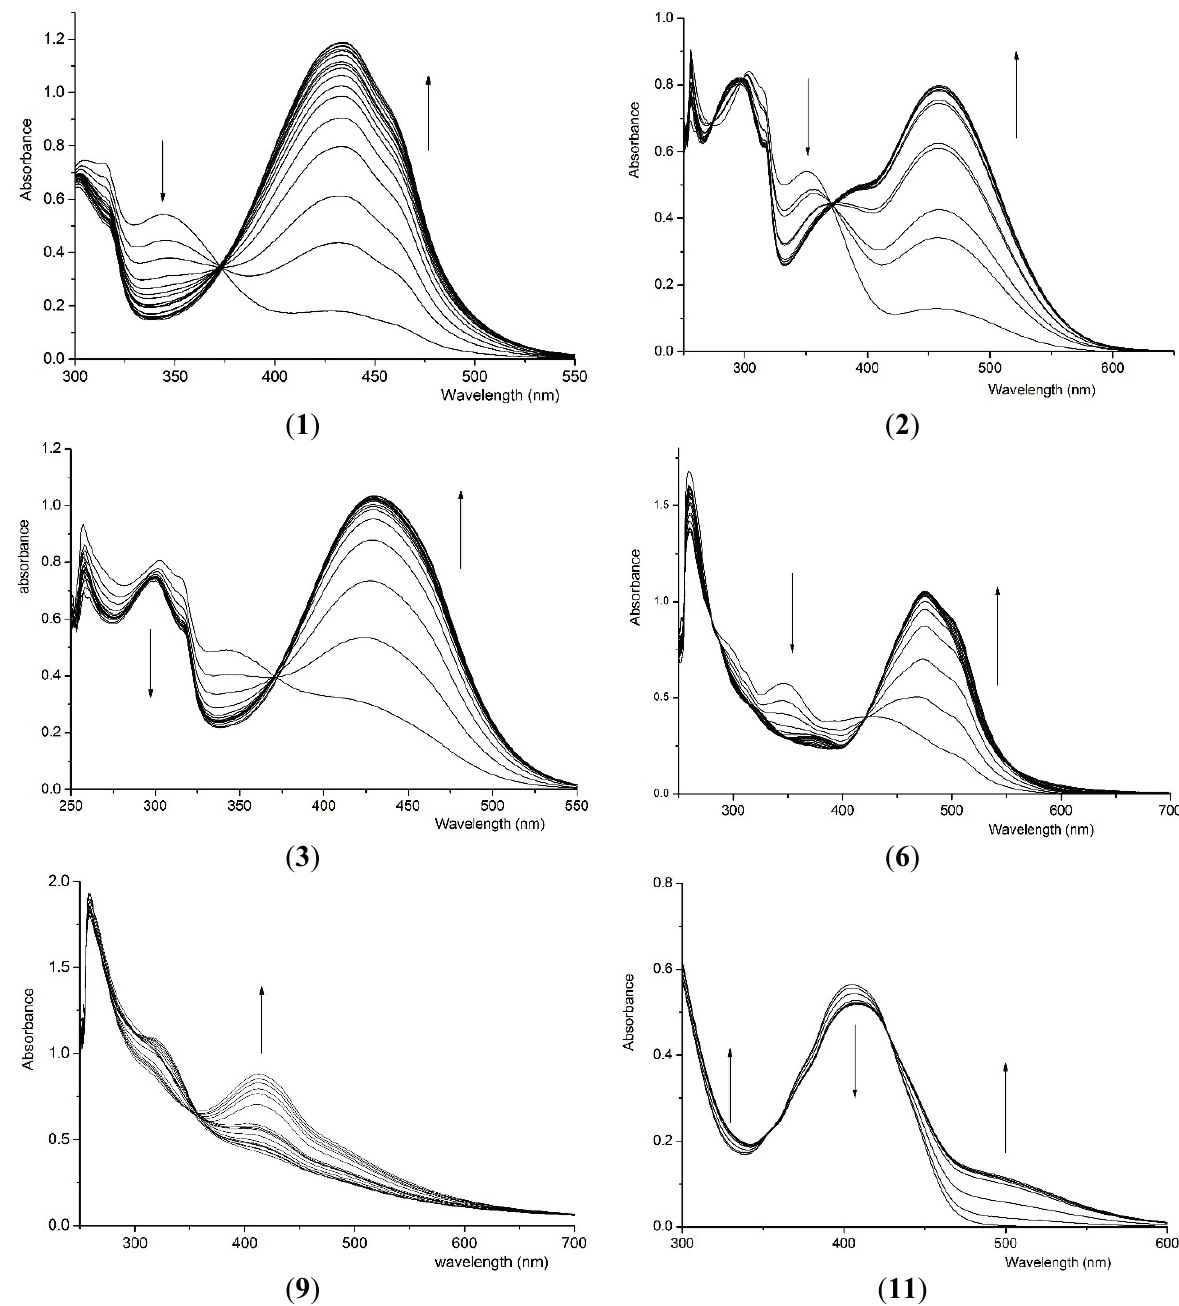
Figure 2. UV-vis spectral changes of various compounds upon the addition of an acetate anion compounds ( 1 , 2 , 3 , 6 , 9 and 11 ). (compound) = 4.0 × 10 − 5 mol·L − 1 ; (acetate anion) = − 1.6 × 10 − 3 mol·L − 1 . Arrows indicate the direction of increasing anion